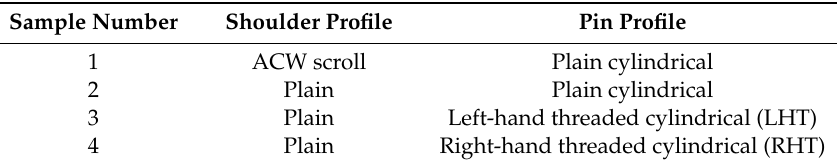
Figure 3. ( a – d ) Models of tool profiles. Table 2. Tool profiles designed for the present study.